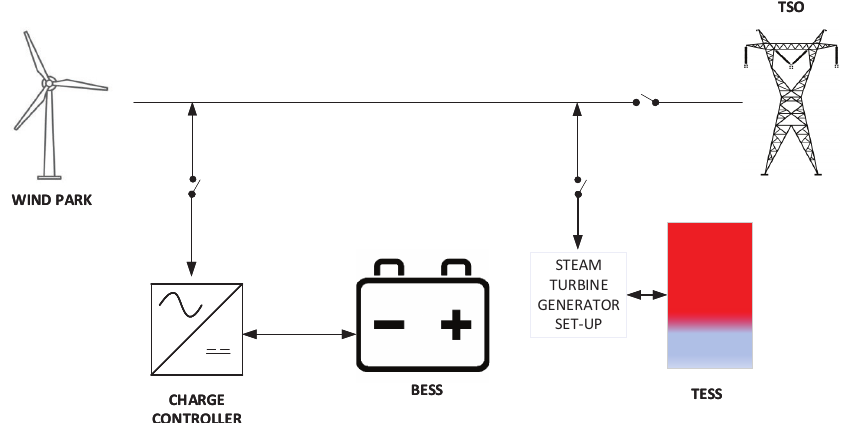
Figure 1. Wind park schematic diagram under study. BESS—Battery Energy Storage System; TESS— Thermal Energy Storage System; TSO—Transmission System